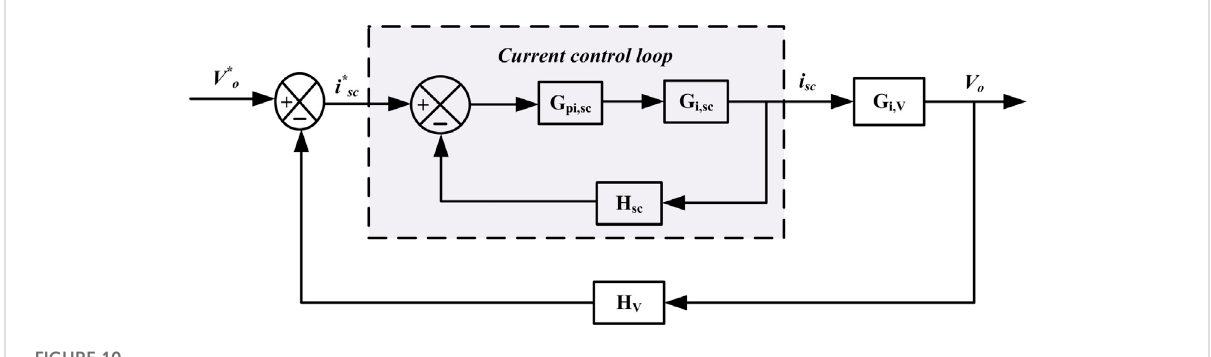
FIGURE 10 SC CCL block diagram.